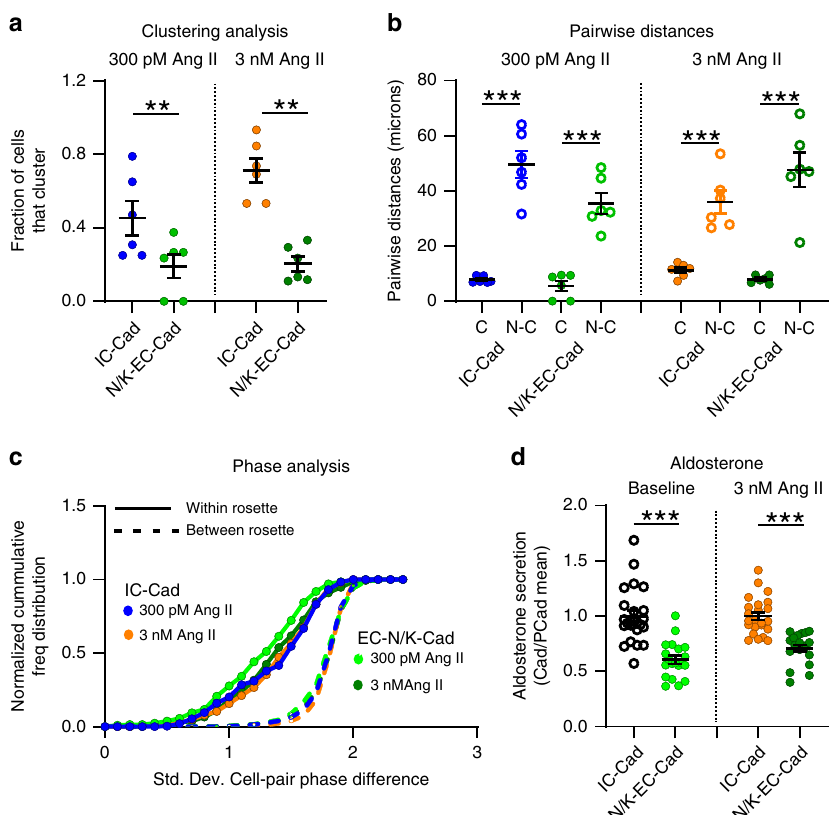
Fig. 8 Cadherin disruption reduces both the number of clustered cells and the production of aldosterone. a Signi fi cantly fewer cells clustered after N/K EC-Abs treatment when stimulated with 300 pM or 3 nM Ang II (means ± SEM: 300 pM Ang II: IC-Ab 0.45 ± 0.19, EC-Abs 0.09 ± 0.06; 3 nM Ang II: IC-Ab 0.71 ± 0.20, EC-Abs 0.07 ± 0.04; 1-way ANOVA, 300 pM Ang II: * P = 0.026; 3 nM Ang II: *** P < 0.0001). b However, cells that remained in functional clusters were proximate (C: clustered; N-C: non-clustered; means ± SEM: 300 pM Ang II: IC-Ab-C 7.77 ± 0.50, IC-Ab-N-C 49.60 ± 4.89, EC-Abs-C 5.55 ± 1.85, EC-Abs-N-C 35.44 ± 3.78; 3 nM Ang II: IC-Ab-C 11.20 ± 1.02, IC-Ab-N-C 35.96 ± 4.13, EC-Abs-C 7.95 ± 0.58, EC-Abs-N-C 47.65 ± 6.30; 1-way ANOVA, 300pM Ang II: IC-Ab C vs C-N *** P < 0.0001, EC-Abs C vs C-N *** P < 0.0001; 3 nM Ang II: IC-Ab C vs C-N *** P = 0.0005, EC-Abs C vs C-N